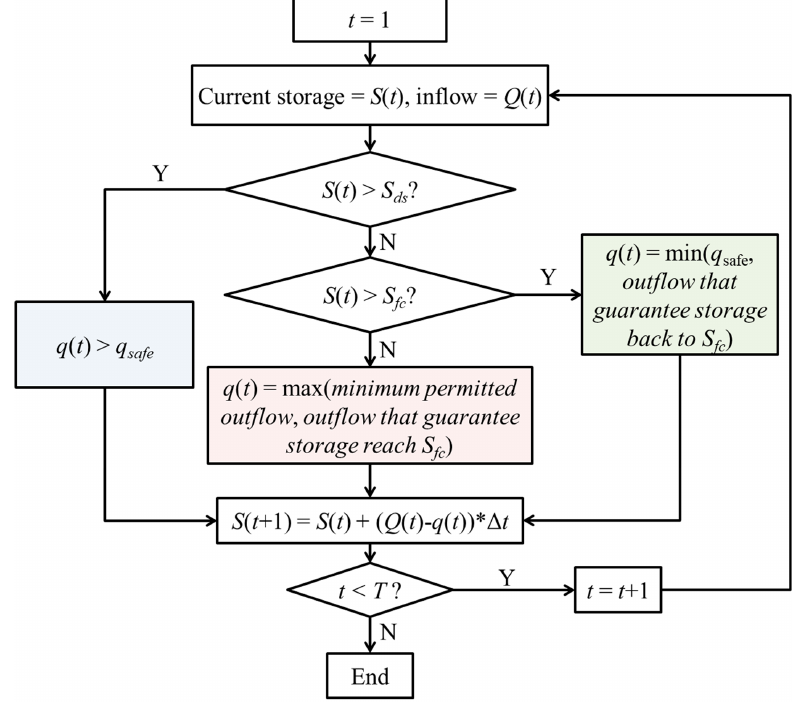
Figure 14. Flowchart of Meishan reservoir flood control operation routing. Table 4. Risk results of the Meishan reservoir for the “Or”